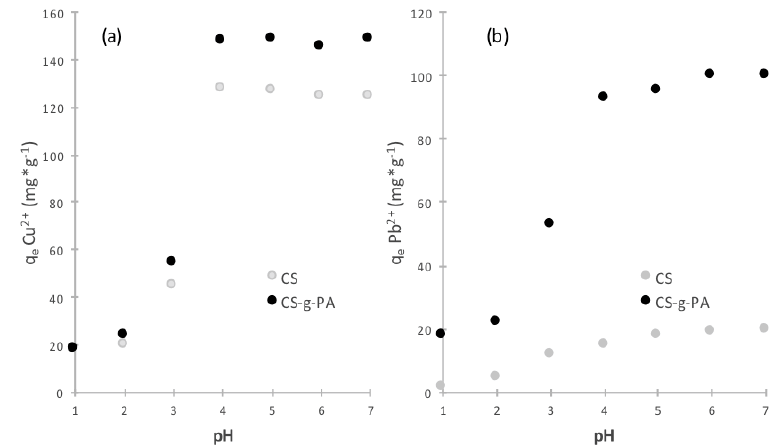
Figure 3. The Effect of initial pH on the adsorption of ( a ) Cu 2+ and ( b ) Pb 2+ on CS and CS- g -PA (adsorption time: 24 h; Initial amount of adsorbent: 25 mg, initial volume of samples: 50 mL, at 25 °C).